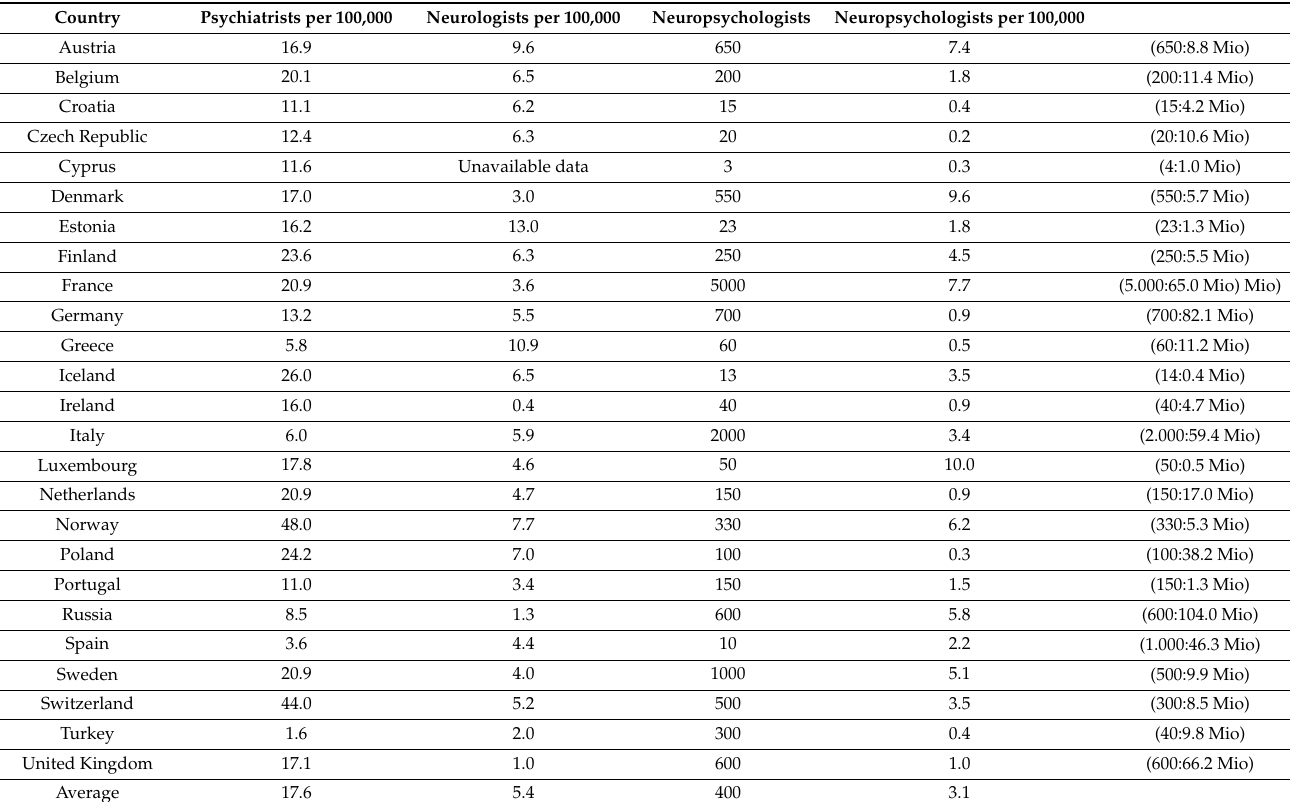
Figure 2. The graphic shows who pays for neuropsychological treatment in a public institution ( n = 24 respondents, dark gray), e.g., a clinic, or in a private institution ( n = 23 answers, light gray), e.g., an outpatient practice. Table 4. Number of psychiatrists, neurologists, and neuropsychologists working in the healthcare sector (the data for the number of neuropsychologists were obtained from the (neuro)psychological societies, and the other information comes from different sources (see notes); Mio =